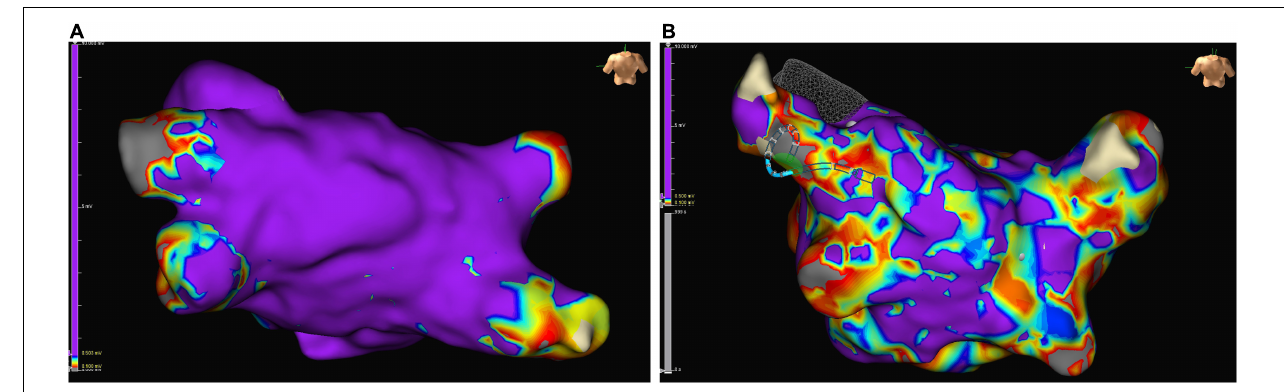
FIGURE 6 | Examples of low-voltage areas in endocardial mapping of left atrium in patients with sinus rhythm who underwent pulmonary vein isolation: normally conducting atrial myocardium is colored purple, low voltage areas (defined as zones with an amplitude of electrical perception of ≤ 0.5 mV) are colored differently. (A) Example of a left atrium almost without low voltage areas. (B) Example of a severely diseased left atrium with low voltage areas >